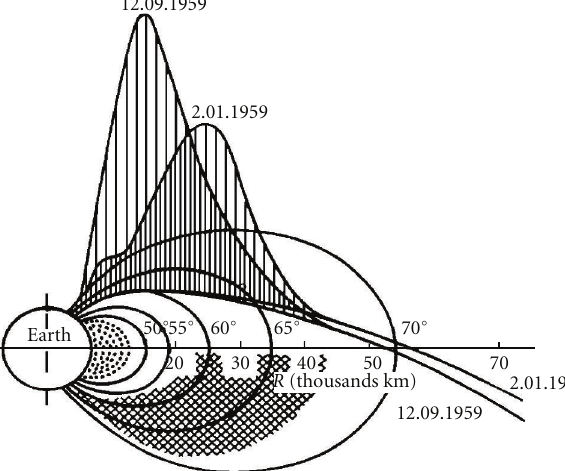
Figure4:IonizationinNaI(Tl)crystalduringtheflightsofthespace Luna-1 (02/01/1959) and Luna-2 stations (12/09/1959) through the radiation belts of Earth.